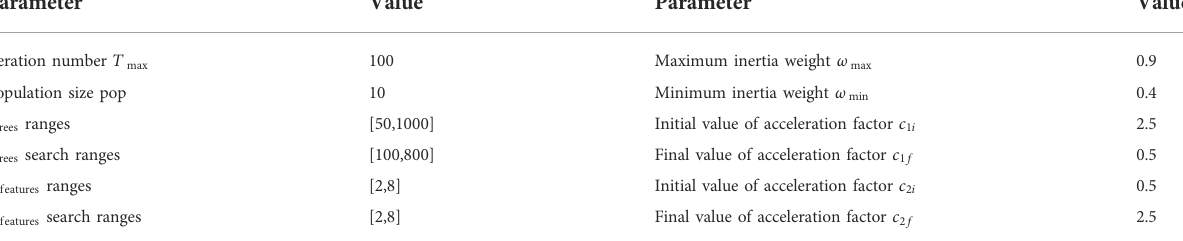
TABLE 1 Parameters of PSO-RF model.